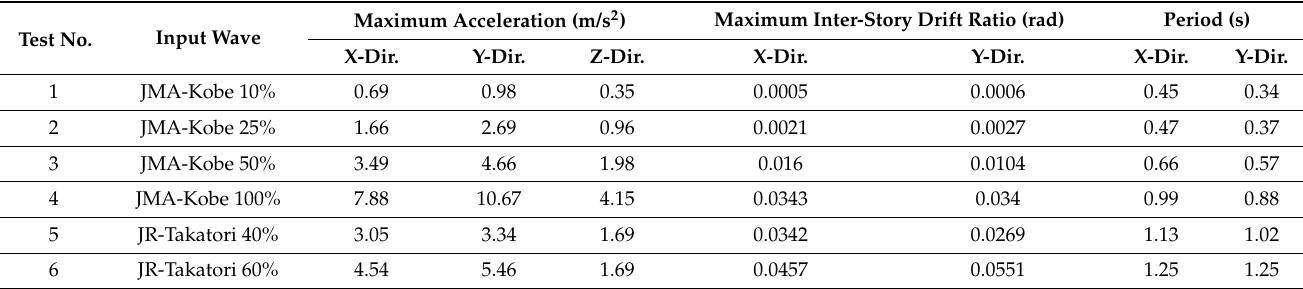
Table 6. Maximum accelerations, maximum inter-story drift ratios, and periods [25].